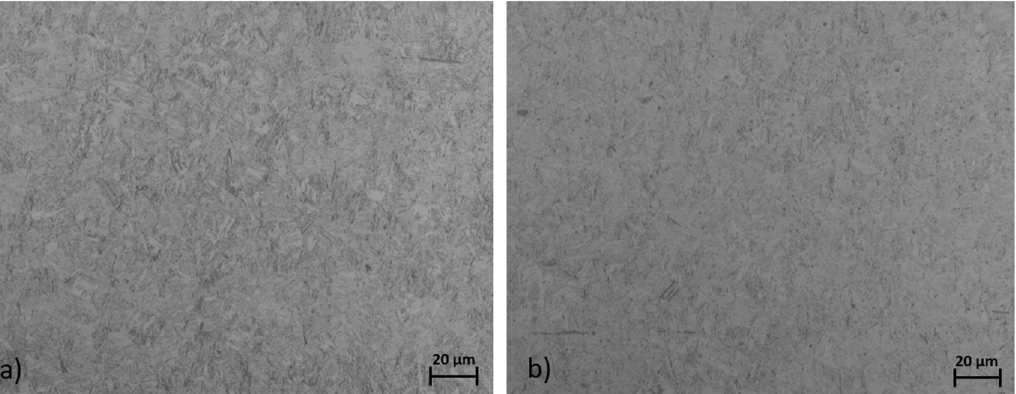
Figure 2. Representative light microscopic images of polished and etched longitudinal sections. The etchant was Nital. ( a ) HT specimen; ( b ) TMT